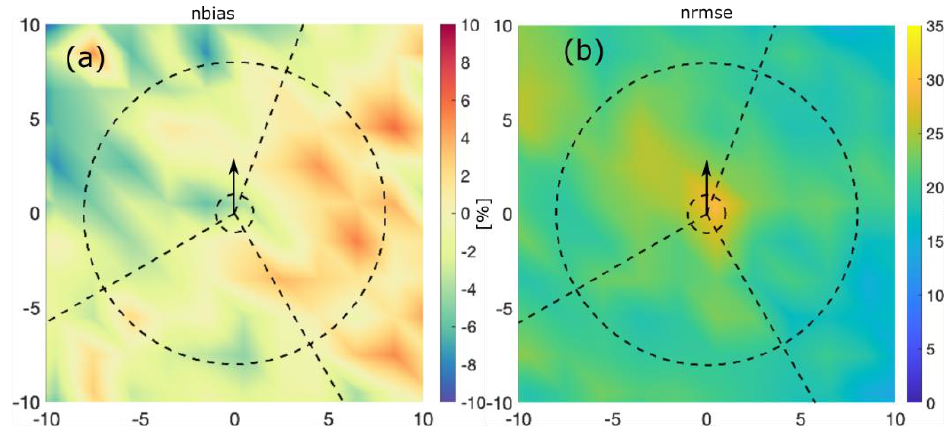
Figure 12. As in Figure 3 for relative bias (a) and nrmse (b). Figure 12. As in Figure 3 for relative nbias ( a ) and nrmse ( b ). Figure 12 is referenced in Section 3.3.4. The correct text now states: